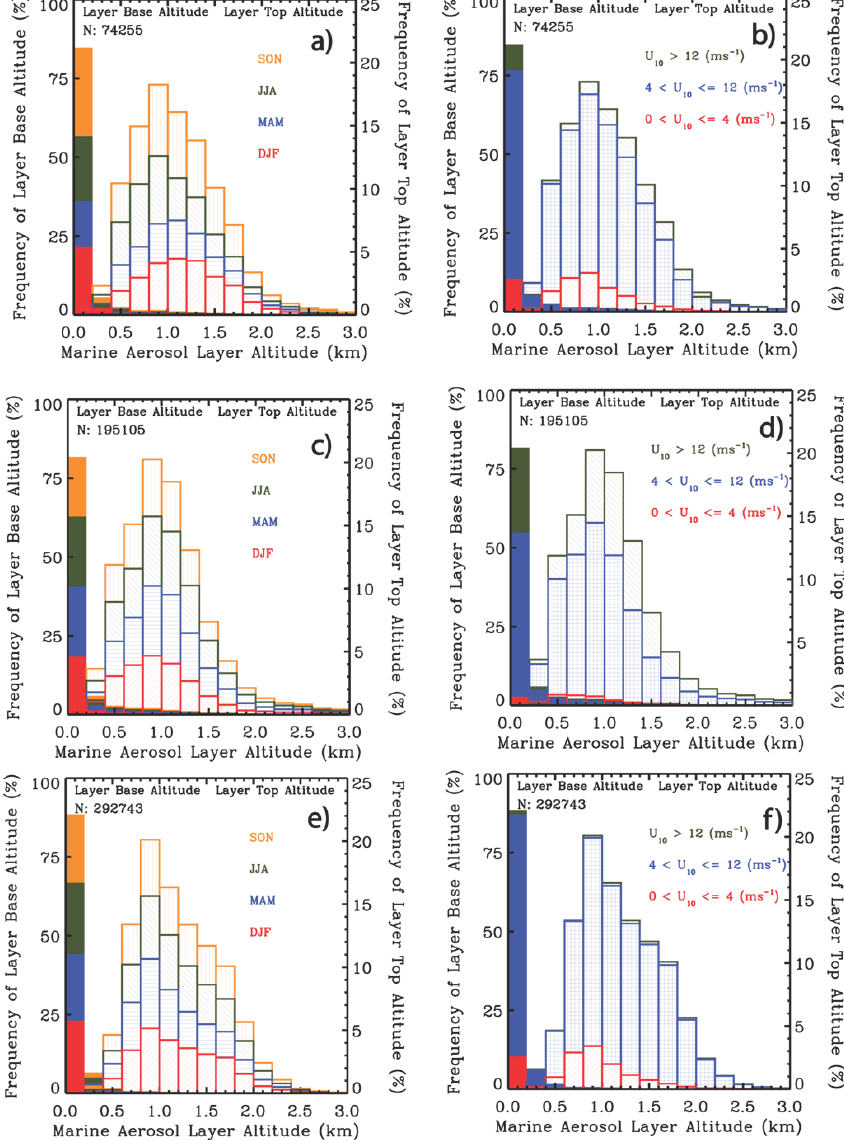
Fig. 3. The CALIPSO lidar frequency histogram of marine AOD 532 aerosol layer base height (solid filled histograms), and aerosol layer top height (line filled histograms) as a function of the season (left) and wind speed (right) for the 15 selected regions over the time period of June 2006 to April 2011. The top panel (a, b) shows aerosol layers for regions 30 ◦ N to 90 ◦ N (regions 10 and 15 on Fig. 1) the middle panel (c, d) for regions 35 ◦ S to 90 ◦ S (regions 1, 2, 3, 4, 6, 8, and 14 on Fig. 1) and the lower panel (e, f) 30 ◦ N to 35 ◦ S (regions 5, 7, 9, 11, 12, and 13 on Fig. 1). Different color bars represent frequency of occurrences for different data